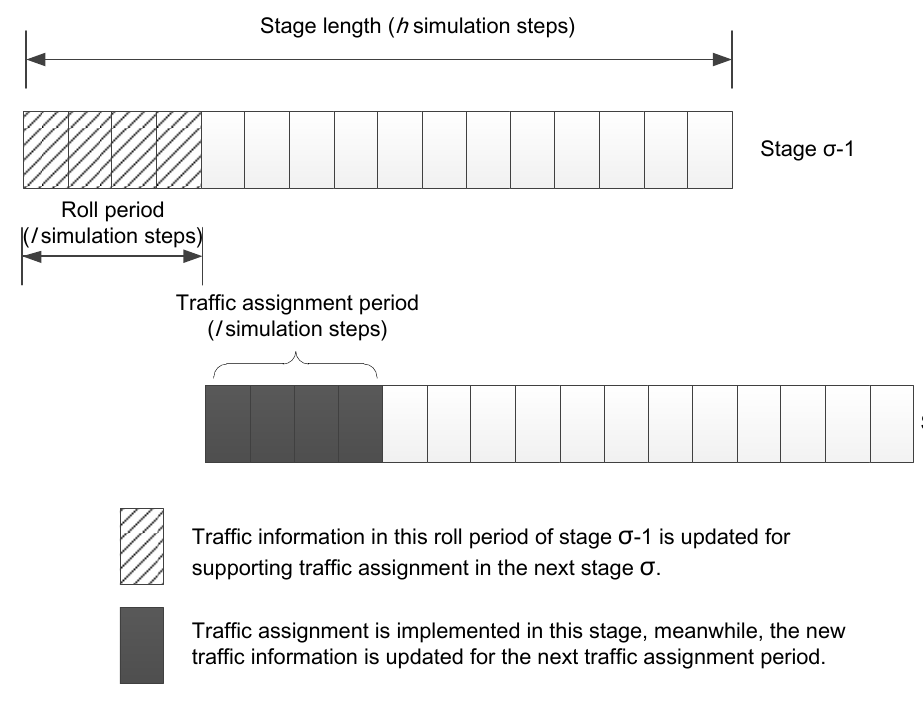
Figure 2. Rolling horizon implementation for updating the traffic network